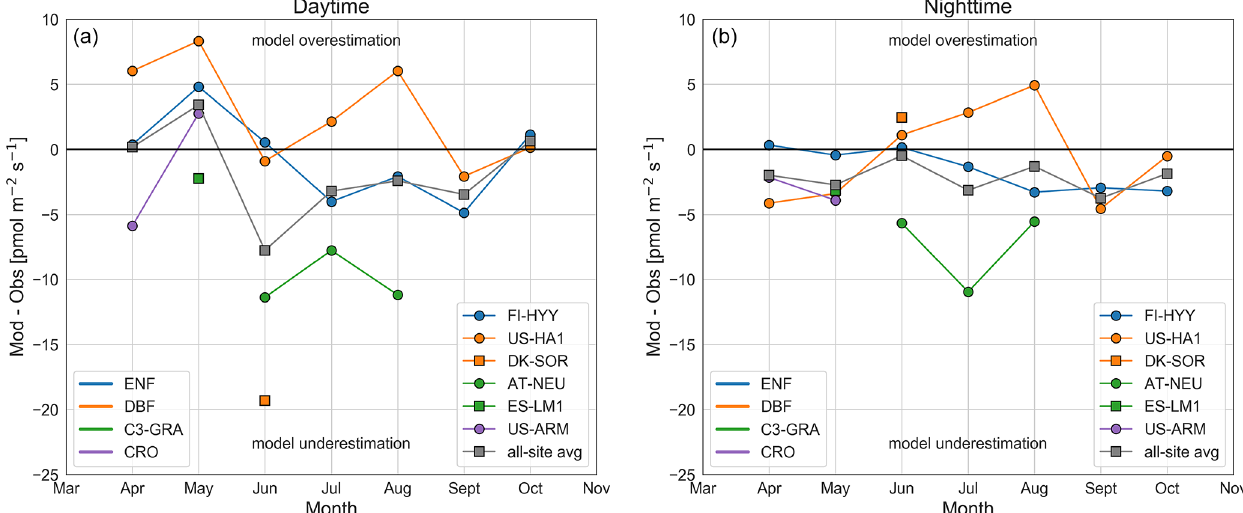
Figure 2. Difference between model simulations and observations of monthly average COS vegetation fluxes (ecosystem–soil) for daytime data (10:00–15:00LT, a ) and nighttime data (21:00–03:00LT, b ). As ecosystem and soil fluxes are needed to obtain the vegetation flux, only sites with these data available are shown here. The model simulations were made with a variable COS mole fraction and the Ogée soil model (SiB4_var_Ogee). Data are colored by PFT (i.e., ENF, DBF, C 3 -GRA, and crops